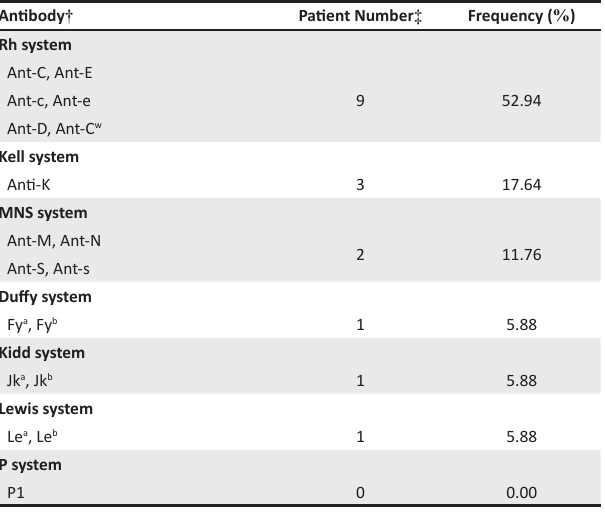
Table 4: Warm alloantibodies in sickle cell patients with multiple blood transfusions who tested positive for alloantibody screening, Bugando Medical Centre, May 2017–June 2017.